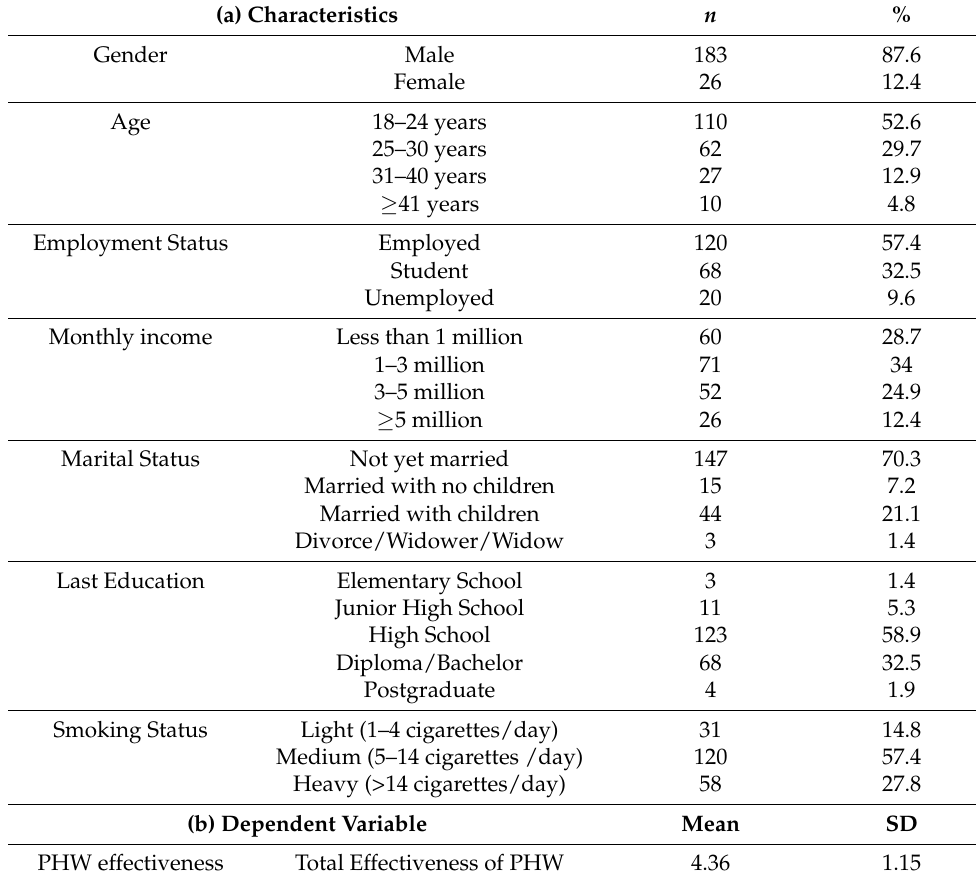
Table 1. Characteristics of participants (all smoker) and PHW